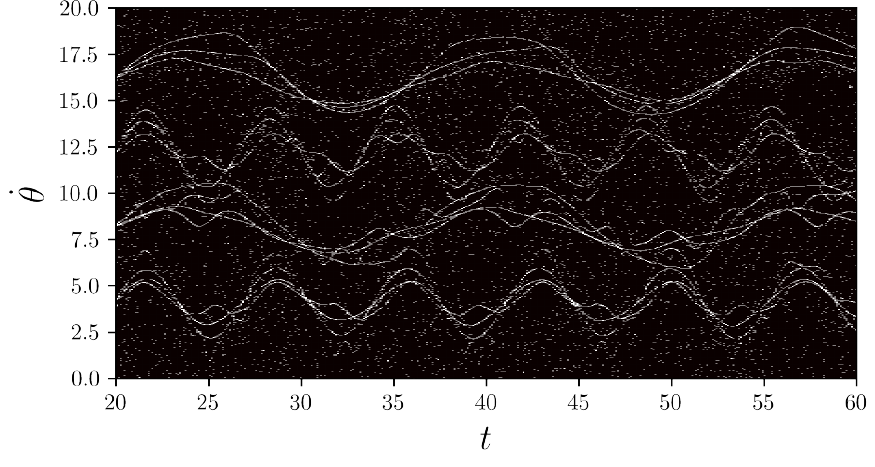
Figure 4. Decompressed matrix B represented as a binary histogram (white bins correspond to the values higher than or equal to 7 × 10 − 3 , while black ones represent values less than 7 × 10 − 3